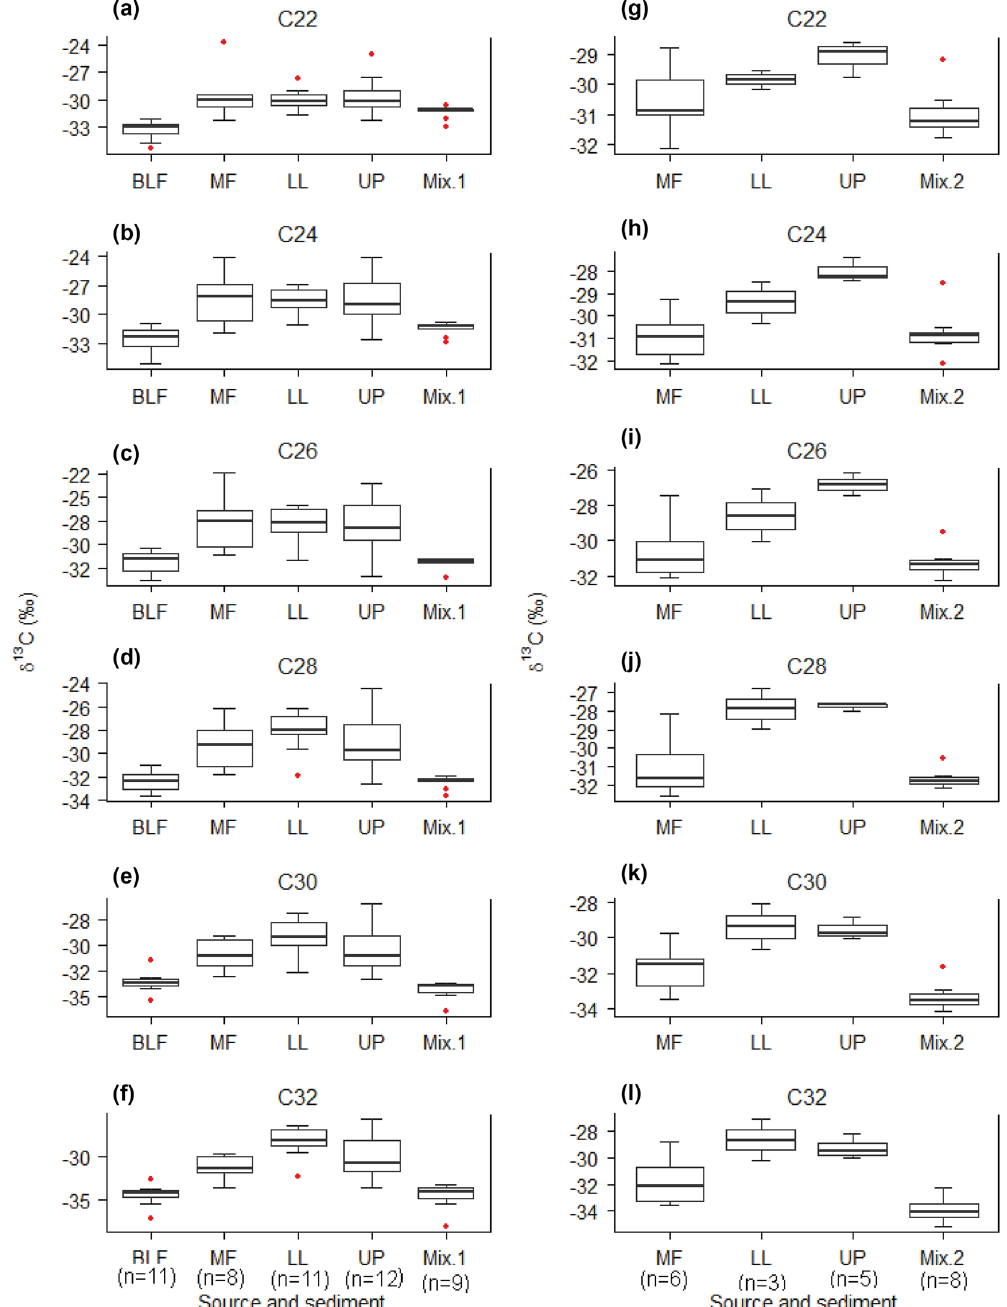
Figure 4. Distribution of δ 13 C (‰) values of FAs (C 22 –C 32 ) in sources and sediments within Dandakharka ( a – f ) and Kharka ( g – l ) subcatchments (for M1 (Mix1) and M2 (Mix2) see detail in Fig. 2b). In box plots, median is shown by central line, interquartile range by box, range by whiskers with circles indicating outliers. Figures in the parenthesis in x-axis indicates the number of samples. Sources: broadleaf forest (BLF), mixed forest (MF), lowland terraces (LL) and upland terraces